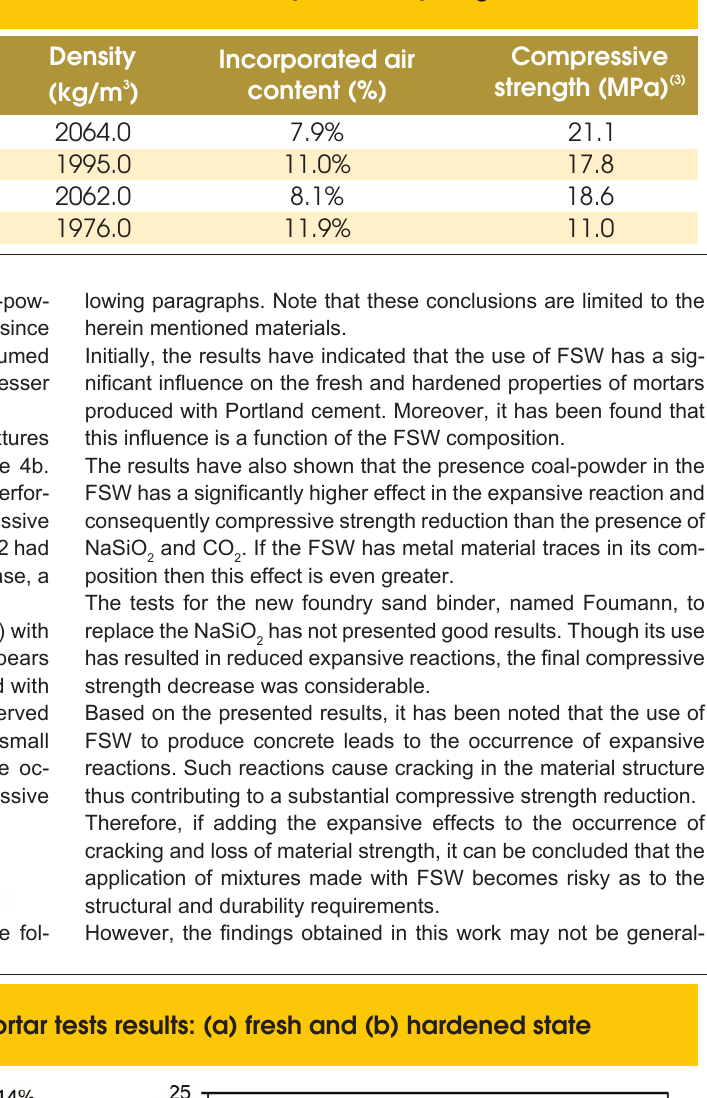
Table 13 – Fresh and hardened state tests results – complementary stage